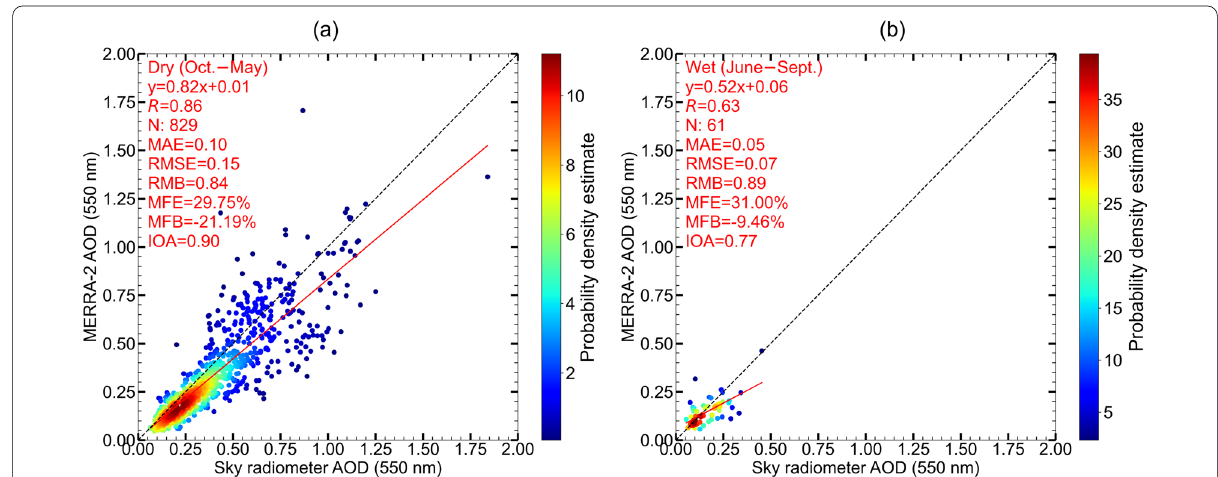
Fig. 2 Scatter density plot of hourly sky radiometer (x-axis) and Modern-Era Retrospective Analysis for Research and Applications version 2 (MERRA-2) aerosol optical depth (AOD) (y-axis) in the a dry and b wet seasons from 2009 to 2019 at the Phimai SKYNET site. Red line: regression line; black dashed line: 1:1 ratio. The color bars indicate the probability density derived from the kernel density